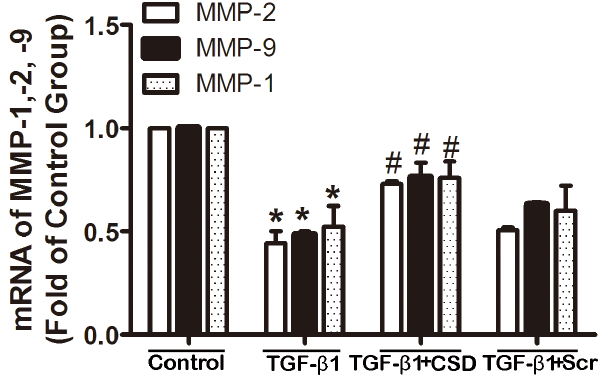
Figure 11. The CSD peptide attenuated TGF- b 1-induced downregulation of MMPs in HAFs. HAFs were pretreated with the CSD peptide (5 m M) or the Scr peptide (5 m M) for 30 min, and subsequently incubated with or without 100 ng/ml TGF- b 1 for 48 h. Note that the CSD peptide remarkably reversed the TGF- b 1-induced downregulation of MMP-1, MMP-2 and MMP-9. MMP, matrix metallo- proteinase. HAFs, human atrial fibroblasts. The CSD peptide, peptides derived from the scaffolding domain of caveolin-1; Scr peptide, scrambled peptide. *P , 0.05 vs. Control; # P , 0.05 vs. TGF- b 1. n=3 per group with each measurement conducted in triplicate.